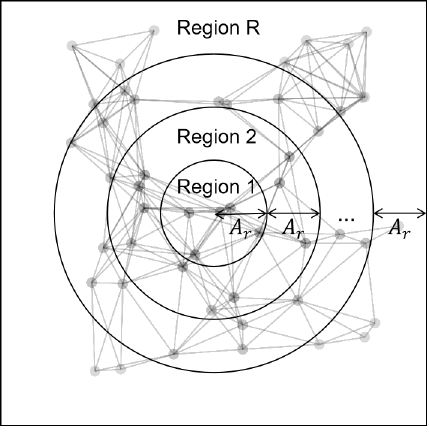
Figure 1. Diagram of